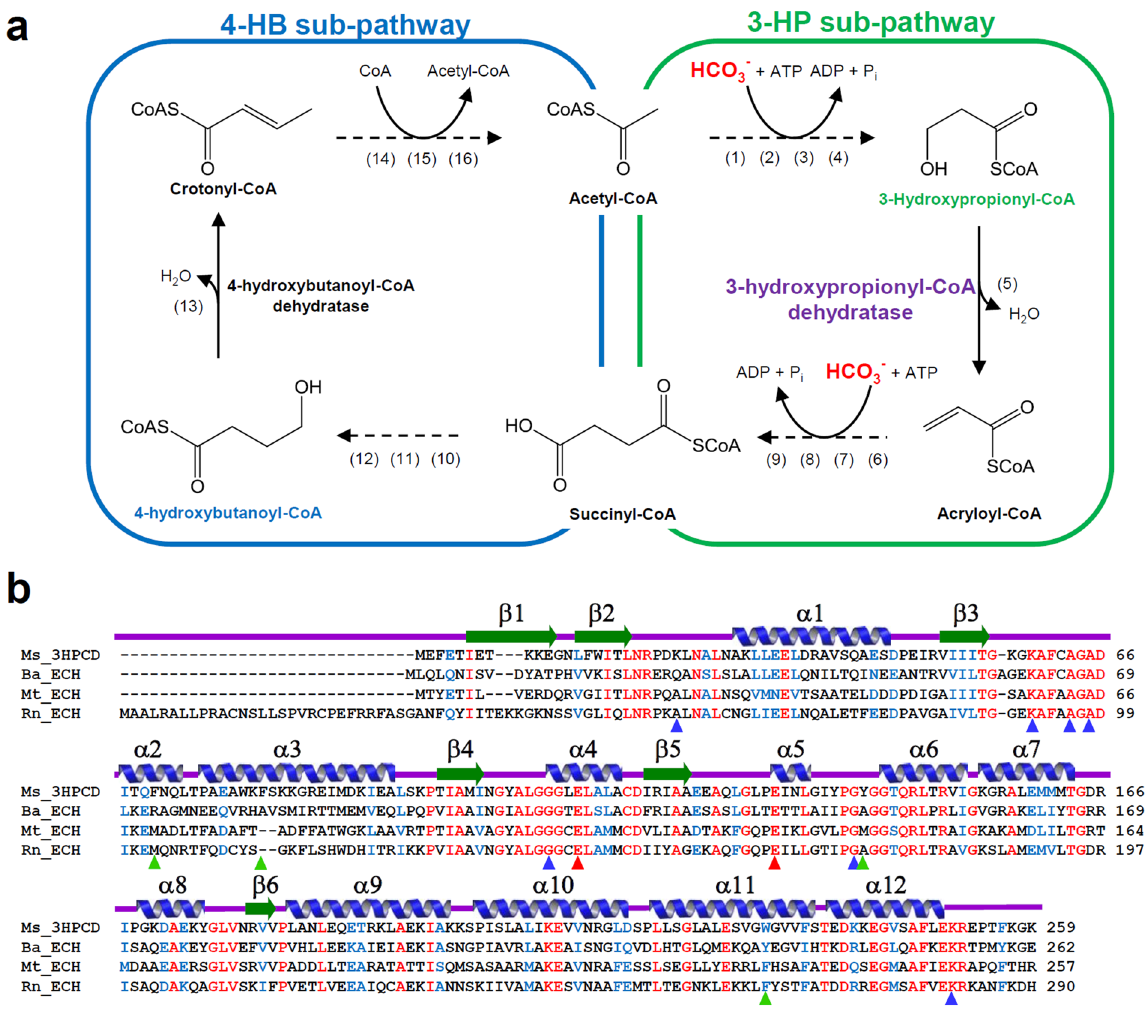
Figure 1. Schematic diagram of the 3-HP/4-HB cycle and amino acid sequence alignment of ECHs. ( a ) Schematic diagram of the 3-HP/4-HB cycle. Enzymes are the following: (1) acetyl-CoA carboxylase, (2) malonyl-CoA reductase (NADPH), (3) malonate semialdehyde reductase (NADPH), (4) 3-hydroxypropionyl- CoA synthetase (AMP forming), (5) 3-hydroxypropionyl-CoA dehydratase, (6) acryloyl-CoA reductase (NADPH), (7) propionyl-CoA carboxylase, (8) methylmalonyl-CoA epimerase, (9) methylmalonyl-CoA mutase, (10) succinyl-CoA reductase (NADPH), (11) succinate semialdehyde reductase (NADPH), (12) 4-hydroxybutyryl-CoA synthetase (AMP forming), (13) 4-hydroxybutyryl-CoA dehydratase, (14) crotonyl- CoA hydratase, (15) (S)-3-hydroxybutyryl-CoA dehydrogenase (NAD + ), (16) acetoacetyl-CoA β -ketothiolase. ( b ) Amino acid sequence alignment of ECH enzymes. The secondary structure elements are drawn based on the structure of Ms 3HPCD. Identical and highly conserved residues are presented in red and blue colored characters, respectively. The residues involved in enzyme catalysis, binding of CoA, and formation of the 3-HP binding pocket in Ms 3HPCD are indicated by red, blue, and green colored triangles, respectively. Ms, Ba, Mt and Rn represent Metallosphaera sedula , Bacillus anthracis , Mycobacterium tuberculosis , and Rattus norvegicus ,